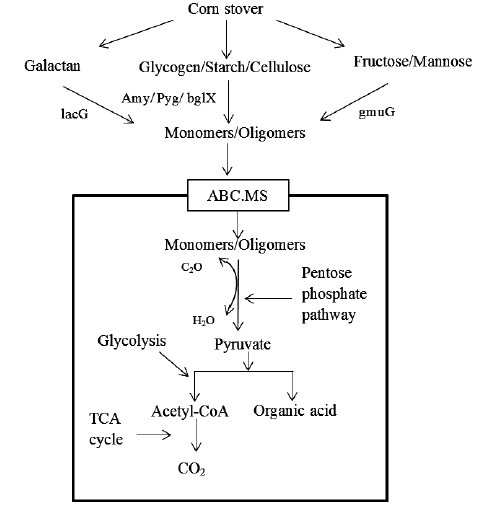
Figure 8. The metabolism model of